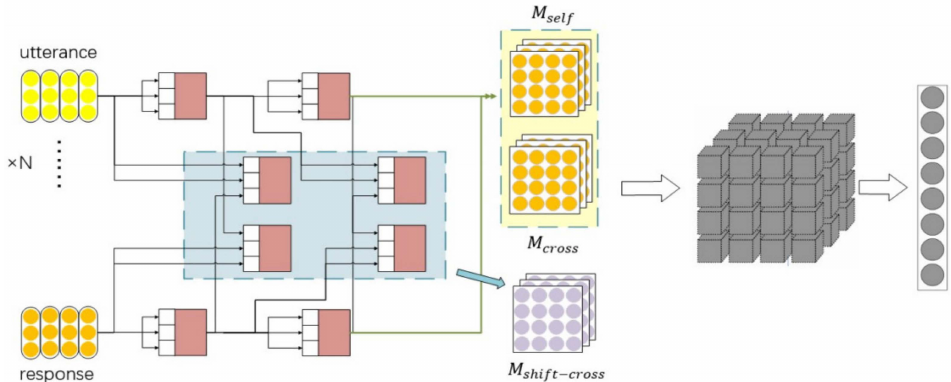
Figure 6. Improved DAM with shifted cross-attention granularity matching method. A new granular representation is generated at the representation part (Blue box), then matched to generate a new matrix (represented in purple), which is finally aggregated with the other two matrices to form a 3D matrix.